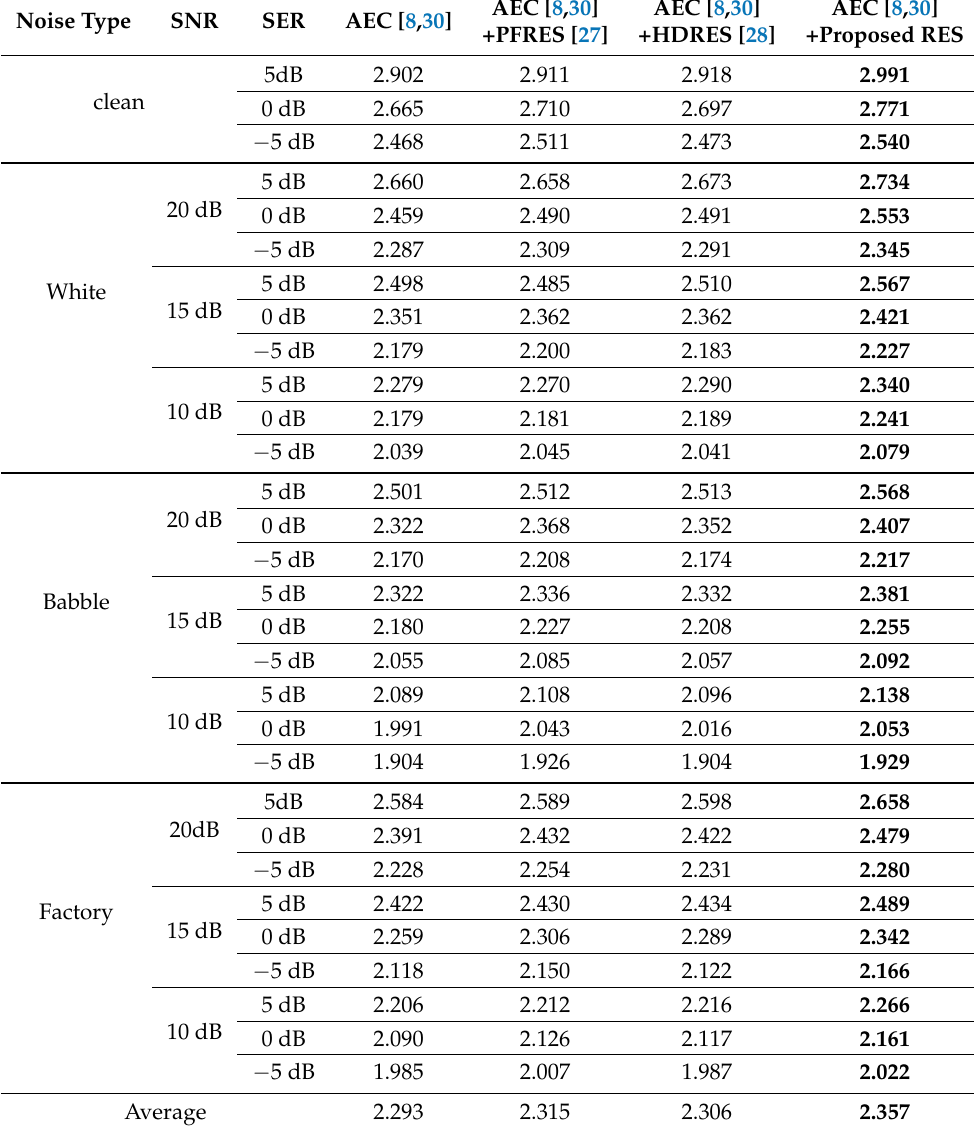
Table 2. Average perceptual evaluation of speech quality (PESQ) scores in various signal-to-noise ratio (SNR) and signal-to-echo ratio (SER) conditions for the AEC without RES, with the PFRES [27], with the HDRES [28], and with the proposed RES during the double-talk periods for the simulated data. The numbers in the bold face indicate the best